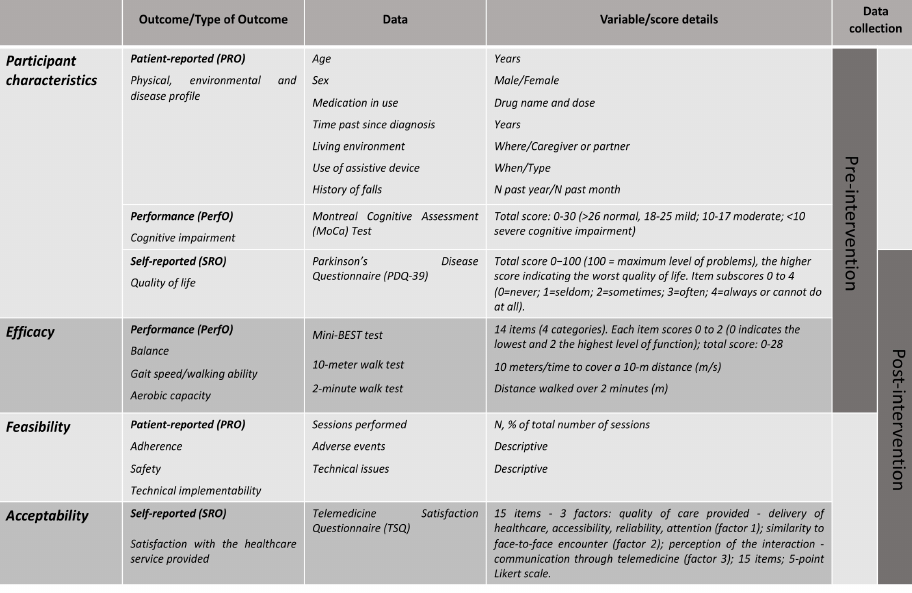
Figure 1. Detailed information about outcomes under study.